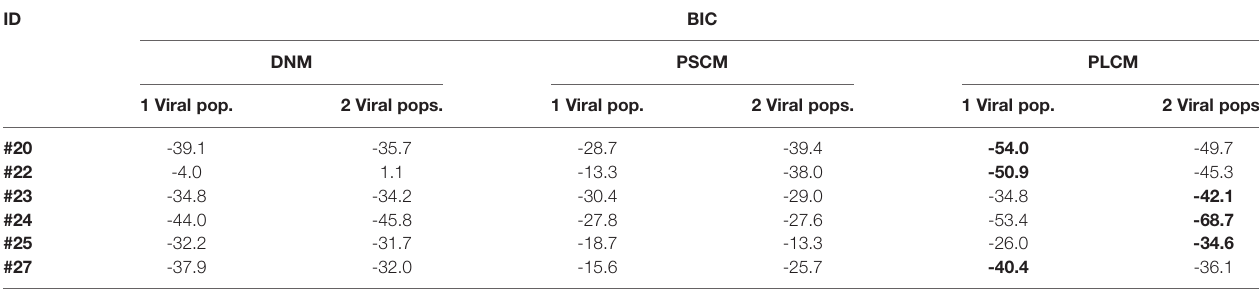
TABLE 2 | BIC values from the best fi ts of each model to each participant ’ s viral load data.